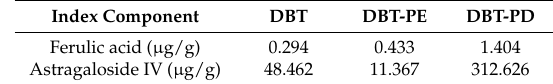
Table 1. Index component analysis of DBT, DBT-PE and DBT-PD.